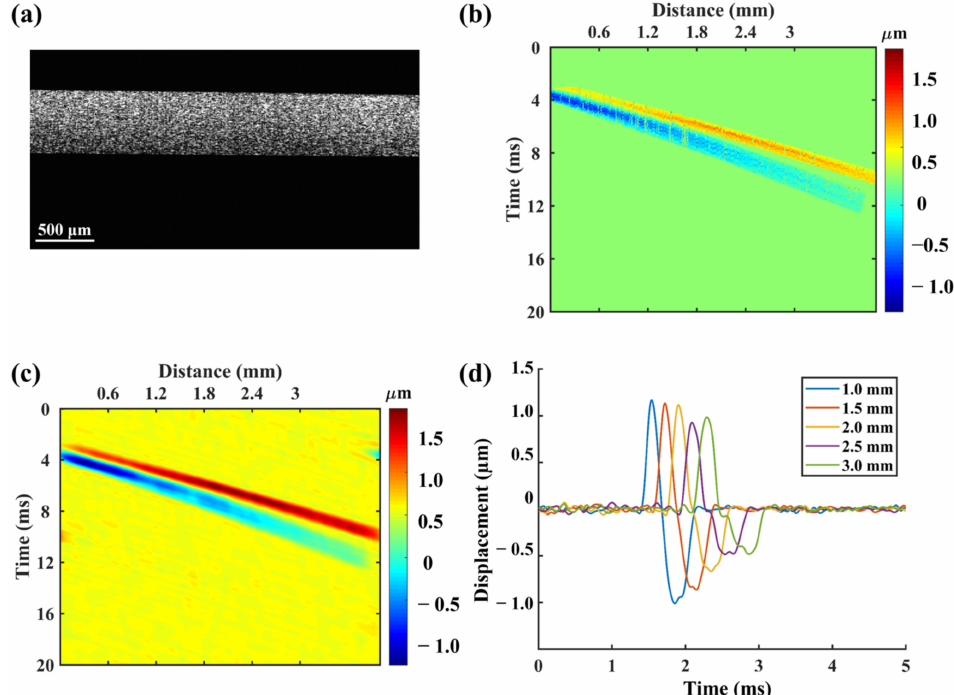
Figure 3. Flowchart of the phase velocity algorithm and mapping results of 0.8% phantom. ( a ) The B-scan OCT image. ( b ) The spatial–temporal displacement map. ( c ) Spatial–temporal displacement map of the filtered elastic wave propagation. ( d ) The displacement curve of different locations along the elastic wave